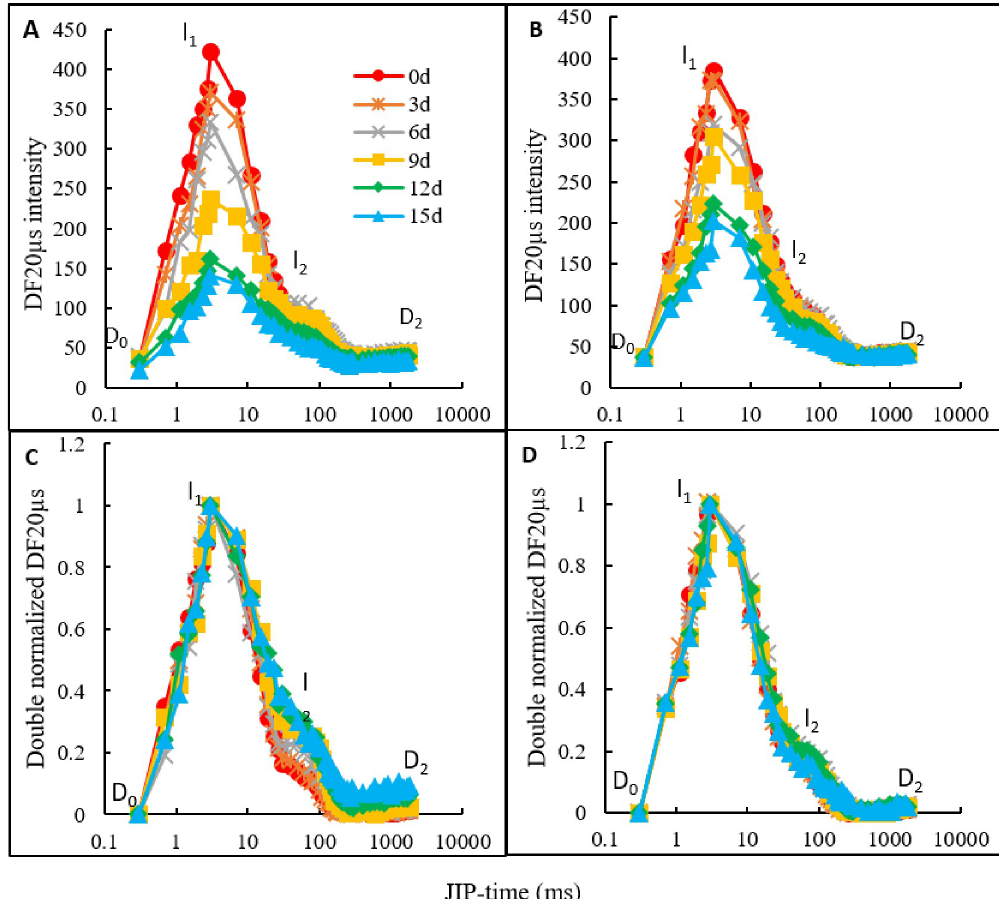
Fig 5. DF induction curves of oat leaves in the NaCl treatment and NaCl treatment with CaCl 2 amendment on the day of NaCl stress and on days 3, 6, 9, 12, and 15 of NaCl stress. (A, B) The absolute values in NaCl treatment and NaCl treatment added CaCl 2 . (C, D) The normalized curves in the NaCl treatment and NaCl treatment with CaCl 2 amendment. The D 0 was the initial value, the peak I 1 was the value at 3 ms, the I 2 was the value at 100ms, the D 2 was the final value of plateau. The signals were plotted on a logarithmic time scale (JIP Time). Each value of the curves is the average of 3 replicates.